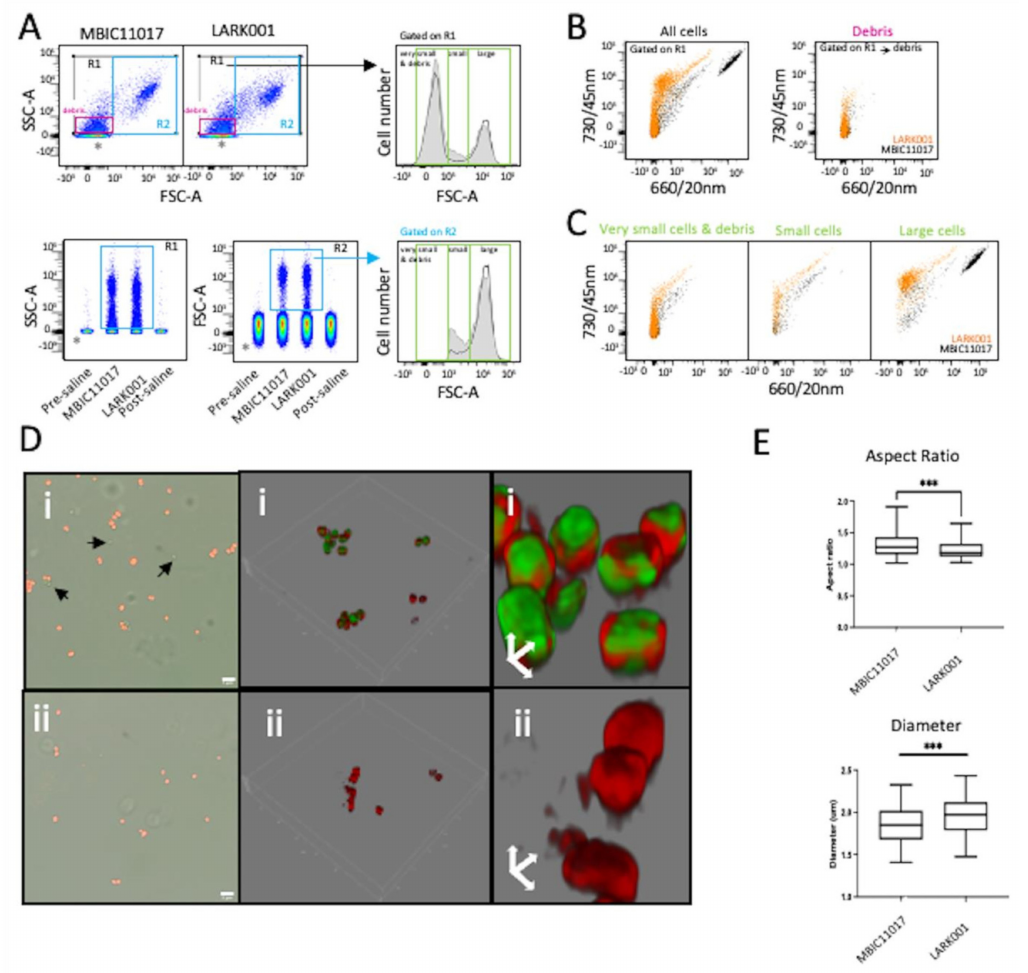
Figure 5. Cytometry and confocal microscopy analysis of A. marina type strains MBIC11017 and LARK001. ( A ) MBIC11017 and LARK001 cyanobacterial cells in FSC-A/SSC-A dot-plots indicating distinct cell populations. Also shown are concatenated SSC-A distribution data, confirming electronic noise events in pre- and post-saline samples (acquired for 1 min). Cell events in R1 exclude electronic noise (*) and demonstrate evidence of two sub-populations based on cell size: designated smaller (R2) and larger (R3) cyanobacteria cells in histogram overlays: MBIC11017 (black unfilled histogram) and LARK001 (grey filled histogram). Tiny debris events are also evident within the R1 gate, but size gating (R4) removes these events. The arrow indicates the shoulder of slightly larger cells within the R2 gated population. ( B ) Two-parameter dot-plots of natural fluorescence at 730/45 nm versus 660/20 nm in A. marina MBIC11017 (black) and LARK001 (orange) strains upon 640 nm red laser excitation. ( C ) Two-parameter dot-plots of fluorescence at 730/45 nm versus FSC-A for R2 and R3 gated events of A. marina MBIC11017 (black) and LARK001 (orange) strains, also upon 640 nm red laser excitation. ( D ) Widefield and confocal images of A. marina MBIC11017 ( i ) and A. marina LARK001 ( ii ) cells (scale bar is 5 mm); also shown are 3-D rendered and zoomed images of the same two strains. ( E ) Aspect-ratio ( n = 107 for MBIC11017 and n = 94 for LARK001) and diameter analysis ( n = 65 for MBIC11017 and n = 73 for LARK001) of cells from microscopy data acquired in D. *** p < 0.005 by a student t